Question: Which visualization type does this figure use?
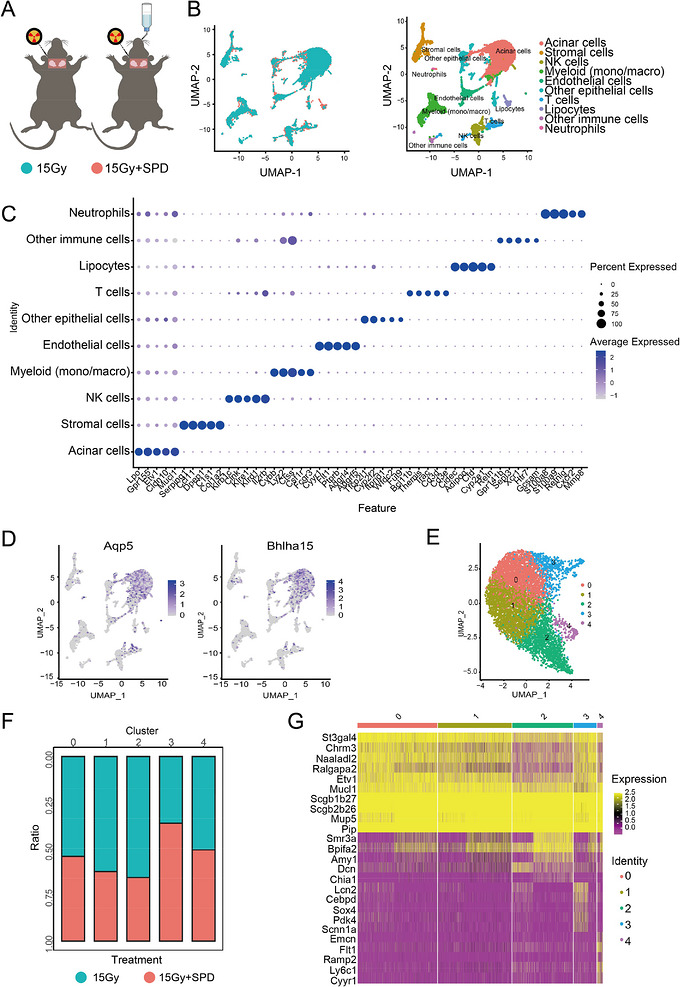
Answer: heatmap